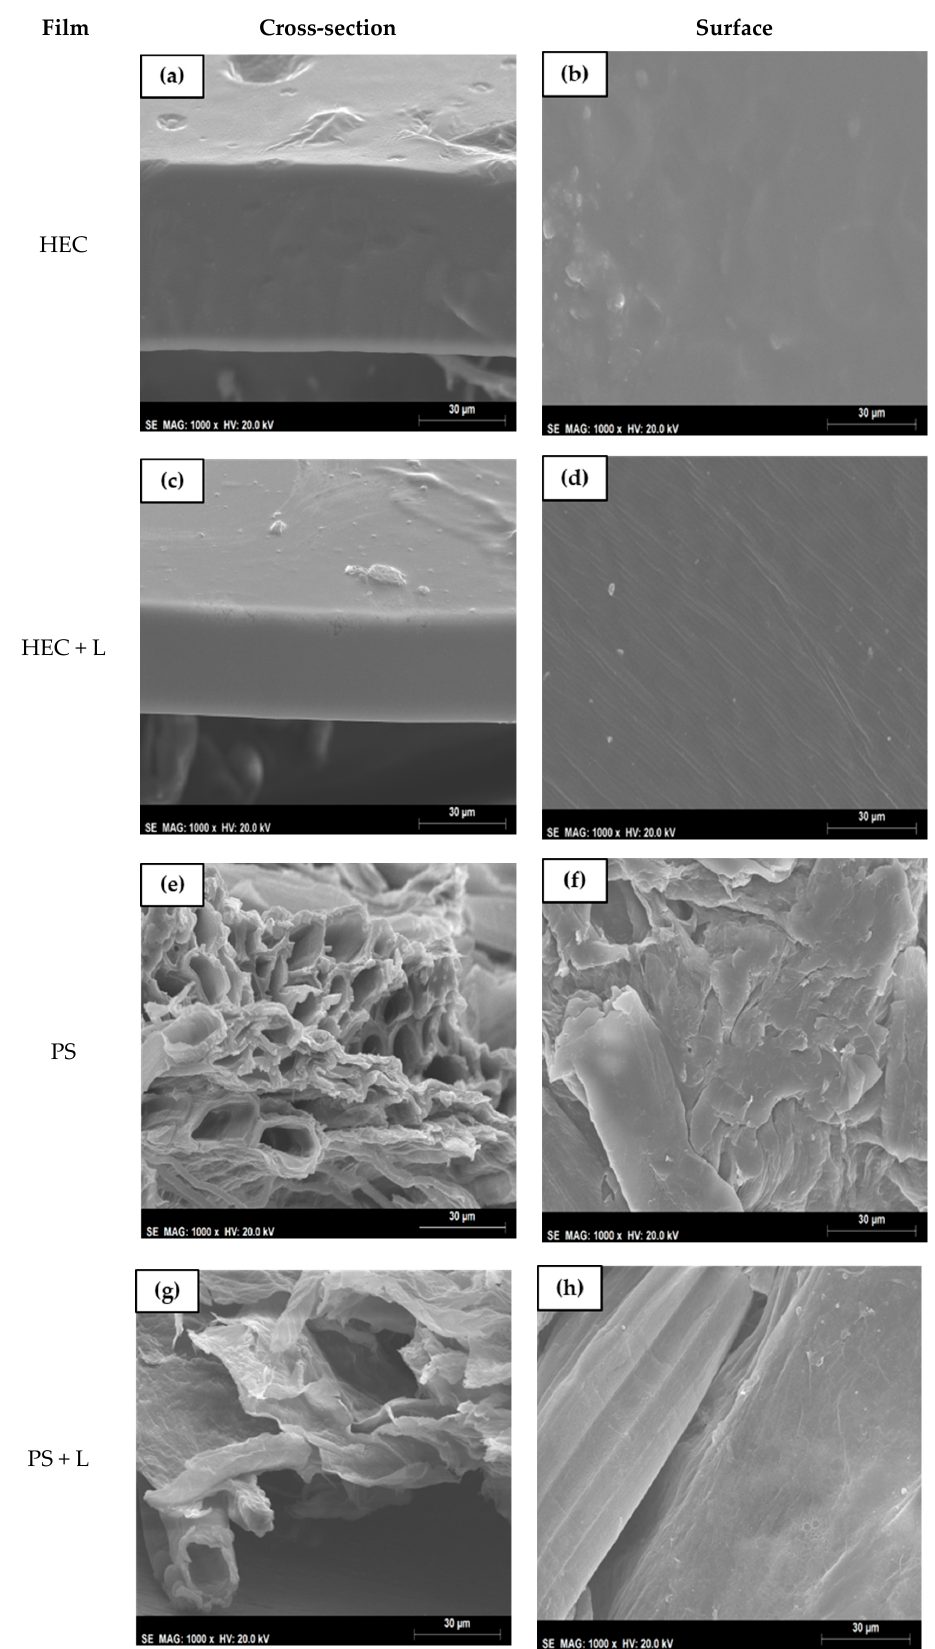
Figure 2. SEM cross section and surface images for HEC ( a – d )—and PS films ( e – h )—exposed to Figure 2. SEMcrosssectionandsurfaceimagesforHEC( a – d )—andPSfilms( e – h )—exposedto0.577a w , with1000 × 0.577 a w , with 1000× magnification.